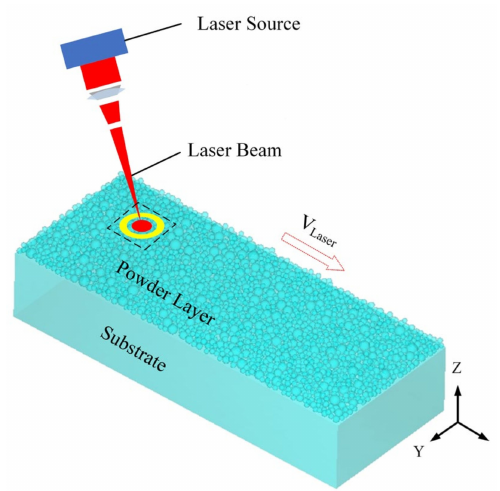
Figure 1. Schematic diagram of the SLM-forming